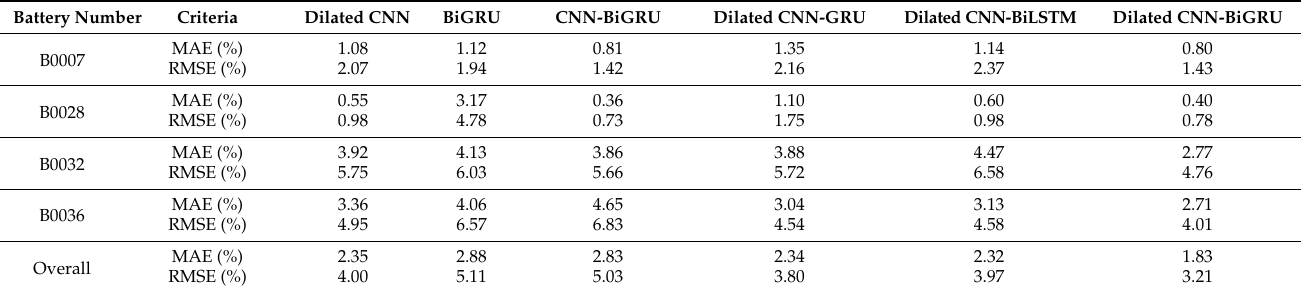
Table 2. MAEs and RMSEs of SOH estimation on the NASA dataset.